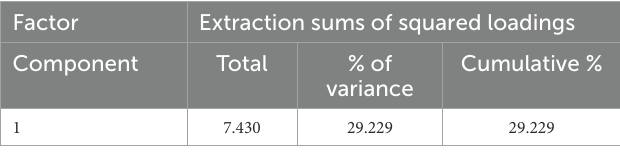
TABLE 3 Total variance explained (Harman’s single-factor